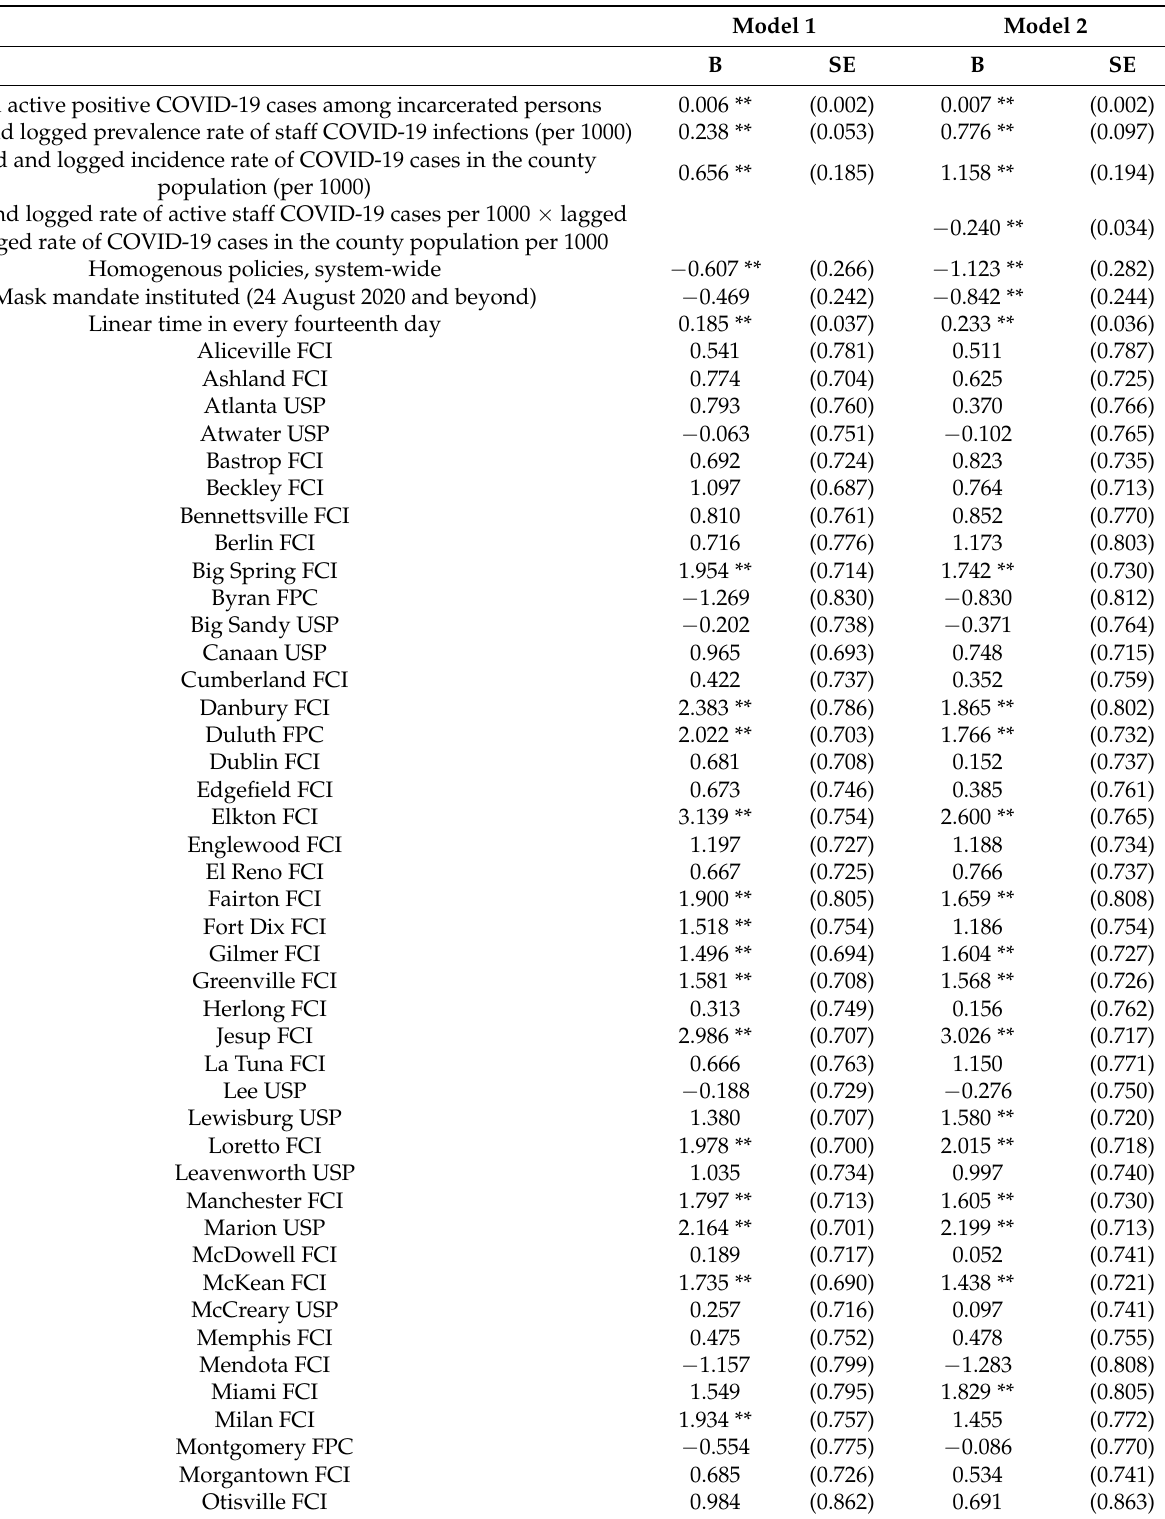
Table A1. Population standardized regressions with prison fixed effects predicting the active cases of COVID-19 among incarcerated